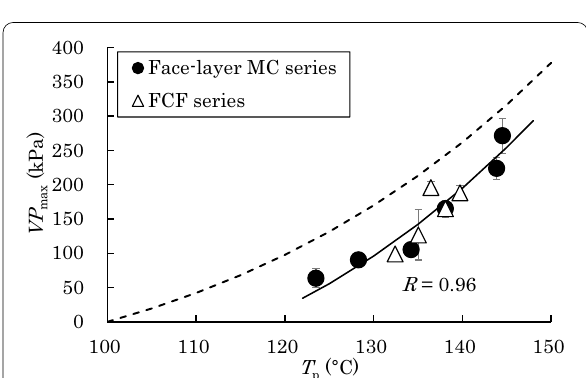
Fig. 8 Plateau-period indices a t 2 and b T p versus total MC for the mats in the face-layer MC and FCF series: the dashed line in a is the regression line of the FCF series